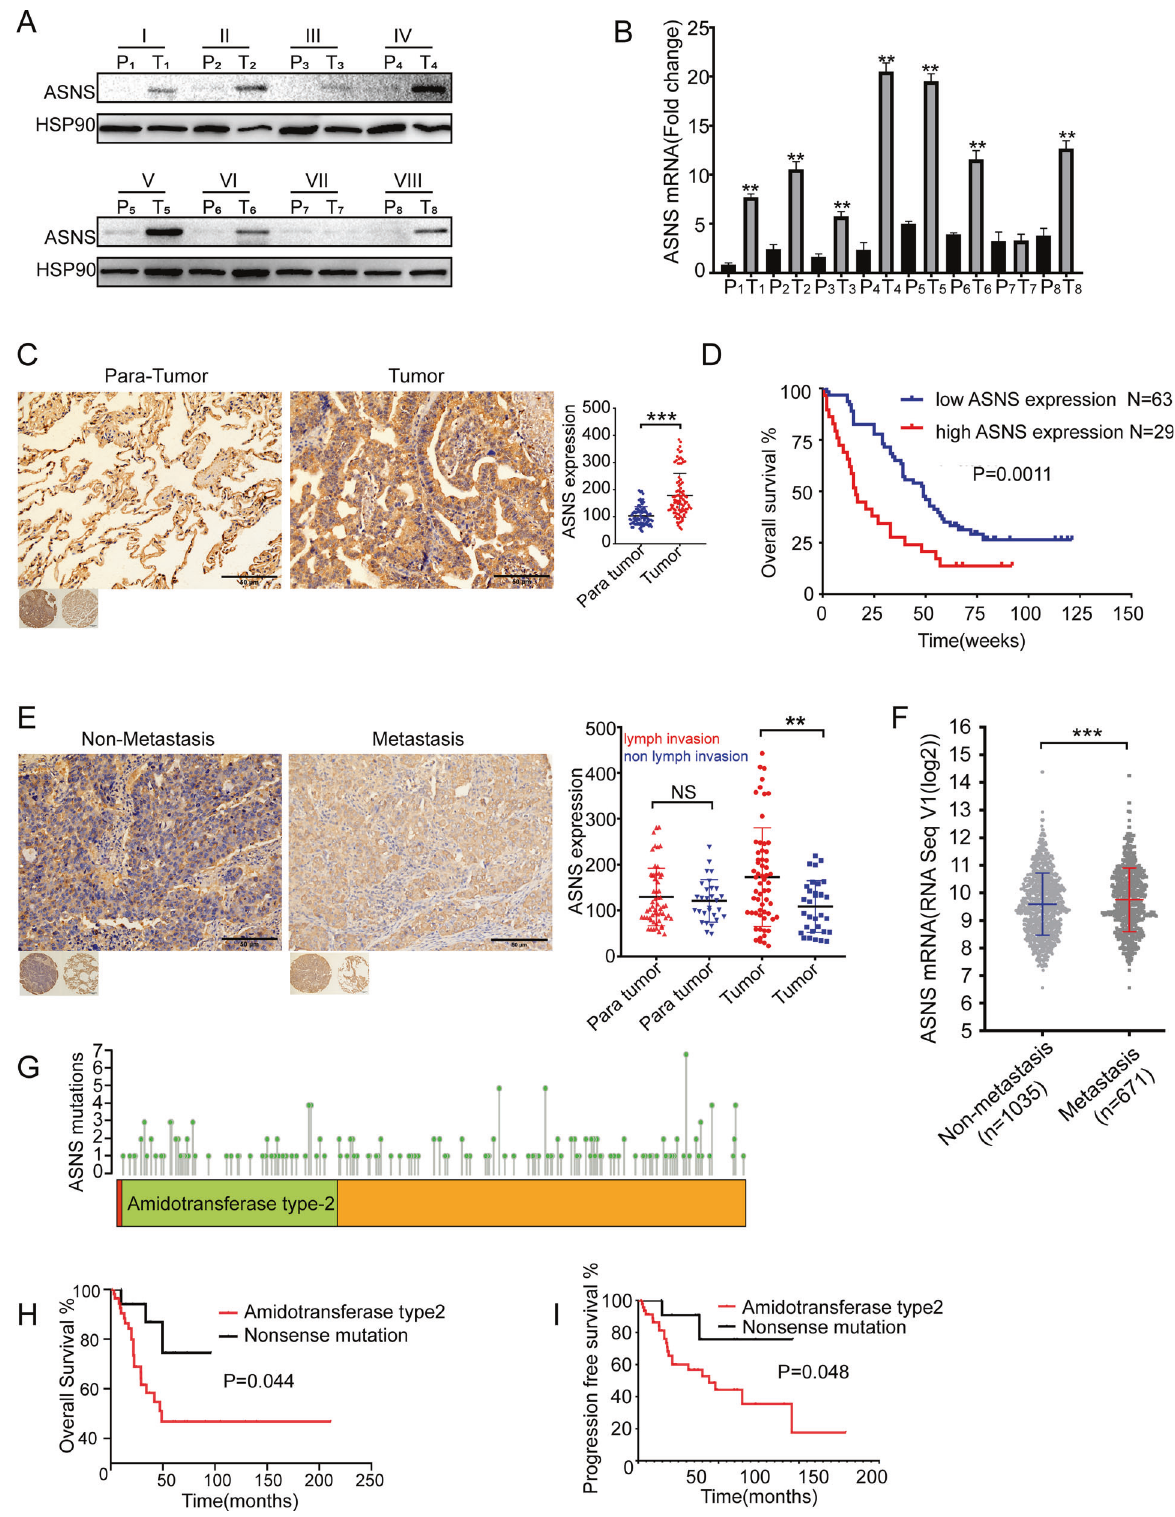
patients with higher ASNS had poor overall survival than those with lower ASNS (Fig. 1D). Furthermore, these patients were classi fi ed into two groups: metastasis and non-metastasis. The metastasis group had higher ASNS level than the non-metastasis group (Fig. 1E). In The Cancer Genome Atlas Program (TCGA)